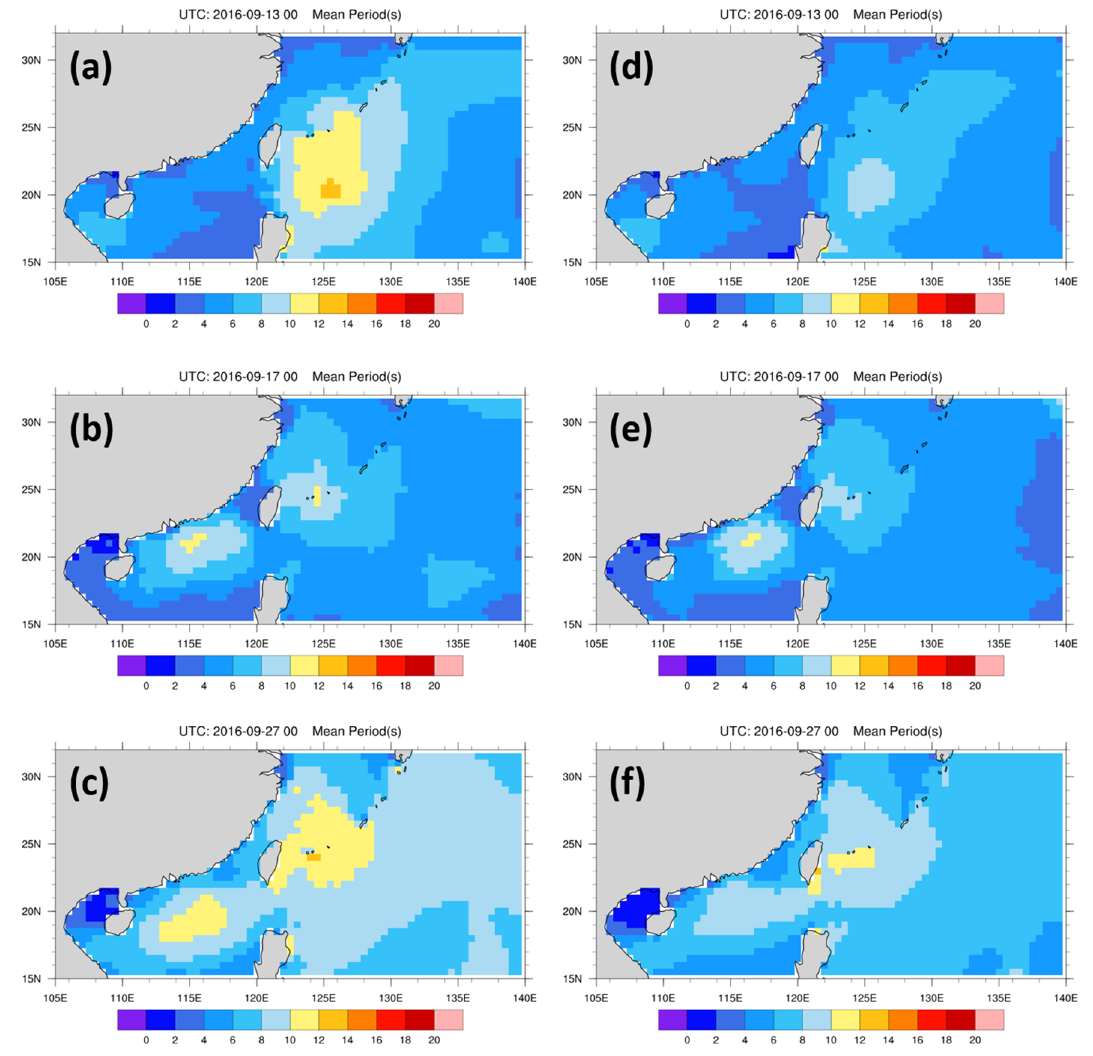
Figure 4. Spatial distribution of mean period driven by the CFSv2 ( a – c ) and the ERA5 ( d – f ) winds; a WW3 model with a 0.50 deg grid resolution was used for Typhoons Meranti ( a , d ), Malakas ( b , e ), and Megi ( c , f ).